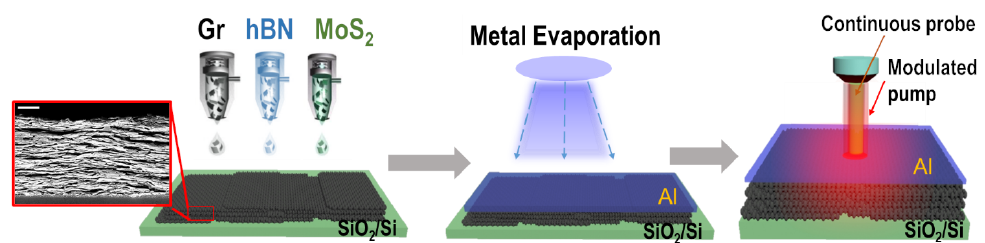
Figure 1. Schematic of the sample preparation for thermal conductivity measurements by pump- probe frequency-domain thermoreflectance. The 2D-material based ink is first prepared by assisted- liquid phase exfoliation, and then inkjet printed on silicon substrate and coated with an Al metal layer. The films are characterized by a dense array of 2D crystal nanosheets (see inset, showing the film cross section, taken by scanning electron microscopy; scale bar = 1 µ m).